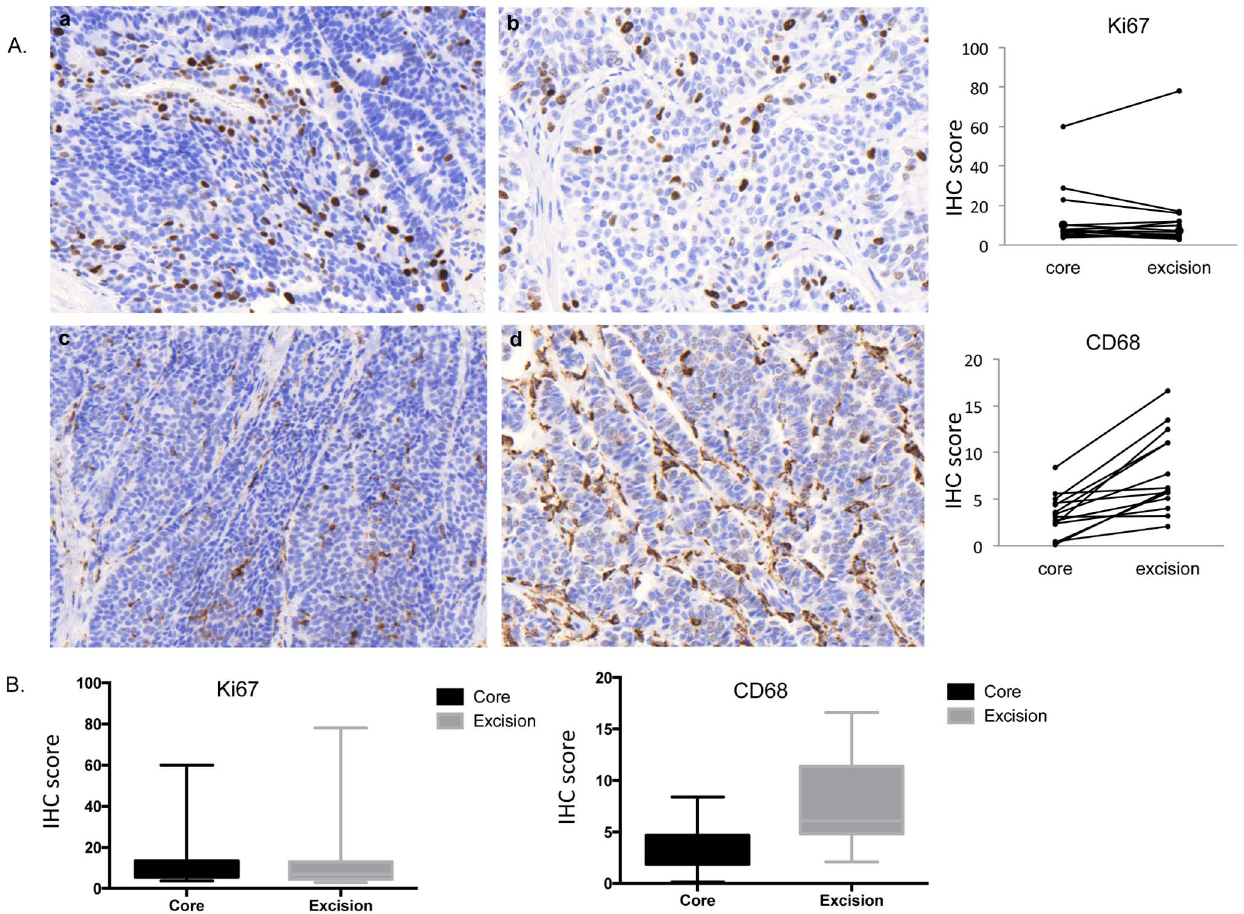
Figure 6. Immunohistochemistry analysis of CNBs and EBs. a and b represent Ki67 staining of CNB and EB respectively and c and d represent CD68 staining in a CNB and EB. Magnification 20 6 . A. Box plots of the Immunohistochemistry scoring for Ki67 and CD68 in the CNB samples and EBs.